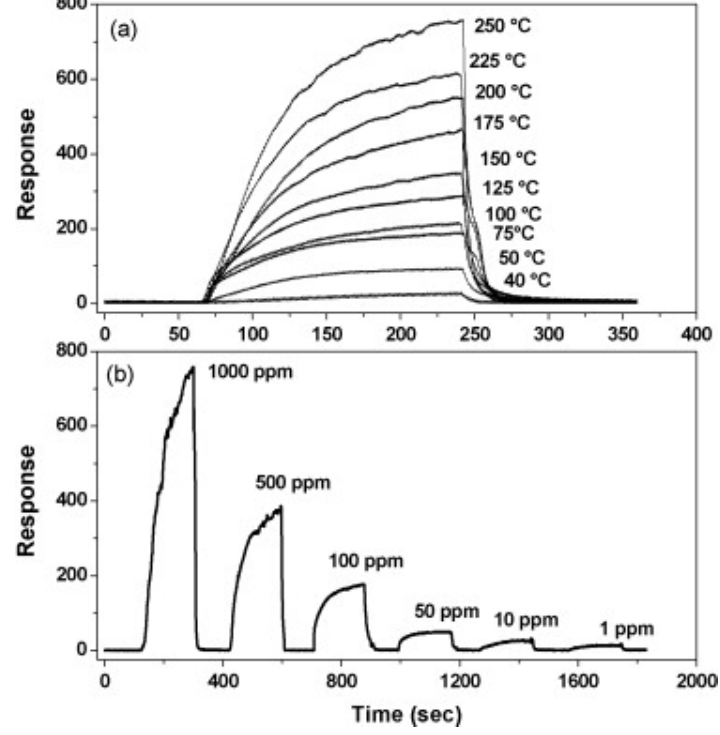
Figure 3. (a) Gas sensing characteristics of tungsten oxide nanoparticles to 1,000 ppm S, and (b) variations in response with concentration of H H 2